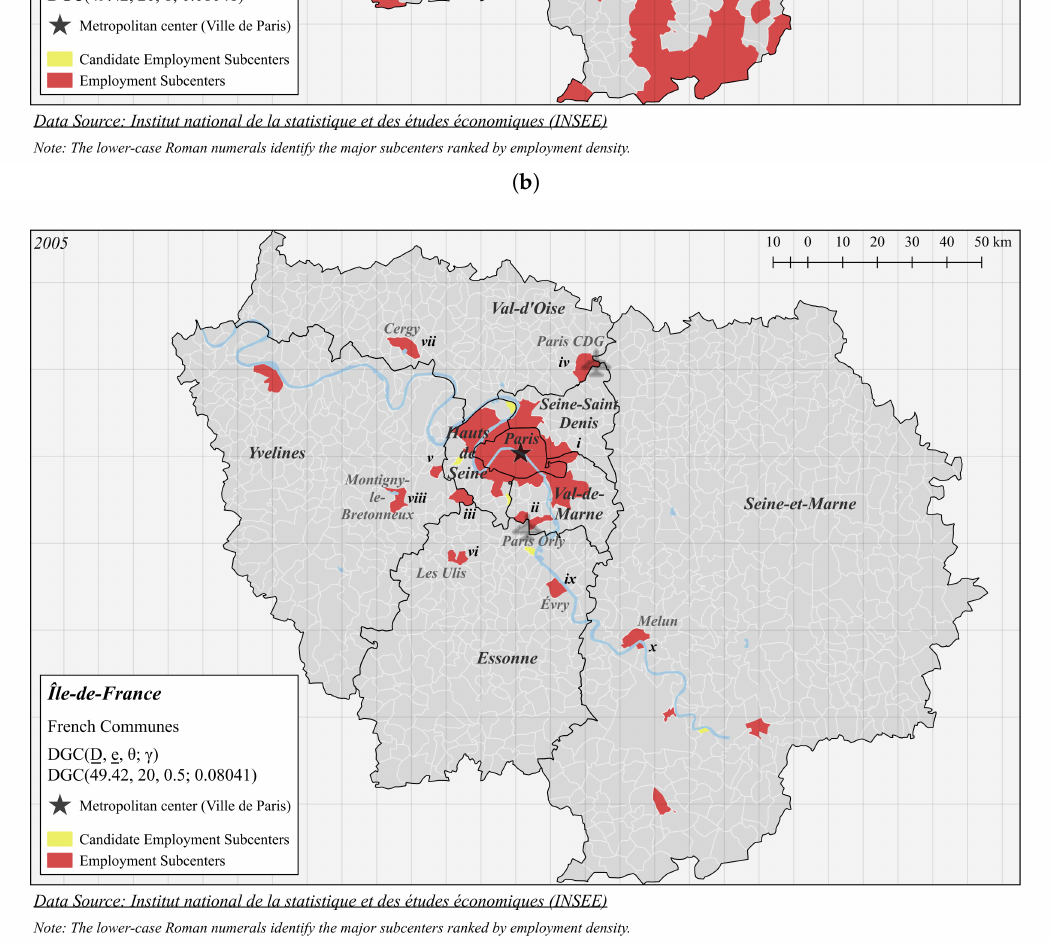
Figure 6. Paris metropolitan area subcenters identified by: ( a ) DGC(49.42, 20, 0; 0.08041); ( b ) DGC(49.42, 20, 1; 0.08041); ( c ) DGC(49.42, 20, 0.5;